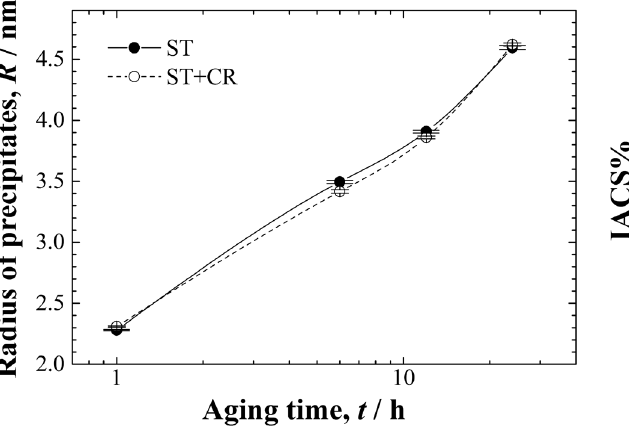
Fig. 9: Variations in the electrical conductivity (in IACS%) of ST and ST + CR specimens aged at 723